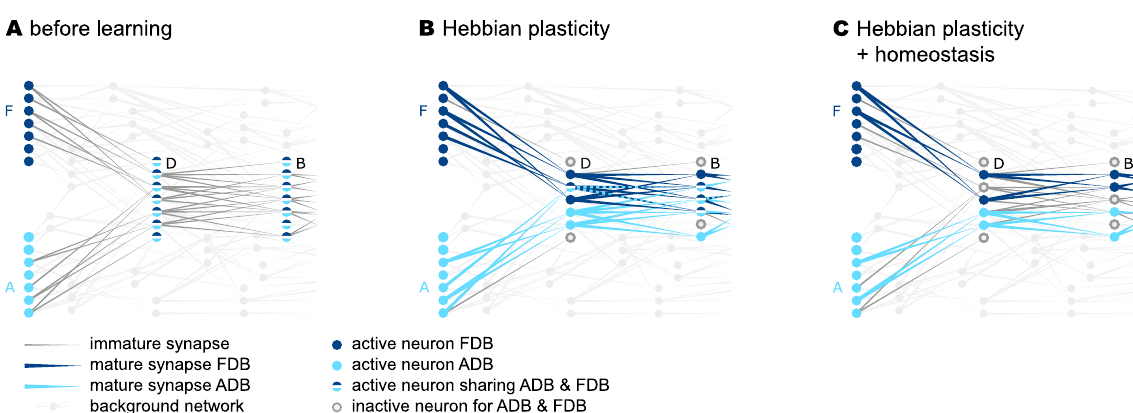
Fig 7. dAP-rate homeostasis enhances context specificity. A) Sketch of subpopulations of excitatory neurons representing the elements of the two sequences {F, D, B} and {A, D, B}, depicted by light and dark blue colors, respectively. Before learning, the connections between the subpopulations are immature (gray lines). Hence, for each element presentation, all neurons in the respective subpopulations fire (filled circles). B) Hebbian plasticity drives the formation of mature connections between subpopulations representing successive sequence elements (colored lines), and leads to sparse firing. The sets of neurons contributing to the two sequences partly overlap. C) Incorporating dAP-rate homeostasis reduces this overlap in the activation patterns.